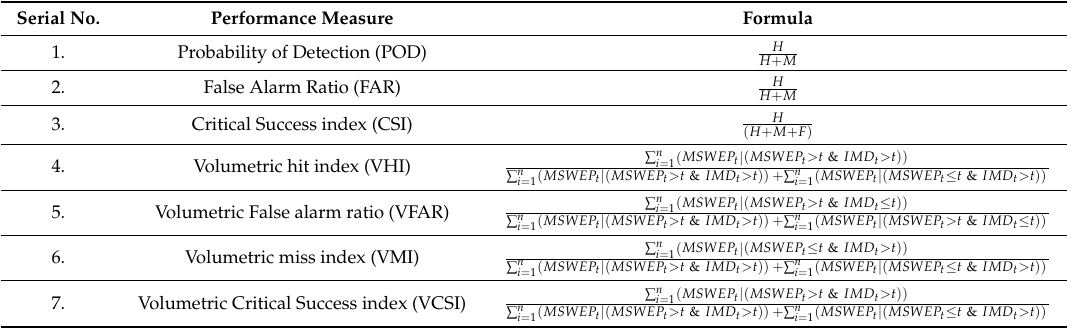
Table 2. List of performance metrics used in the